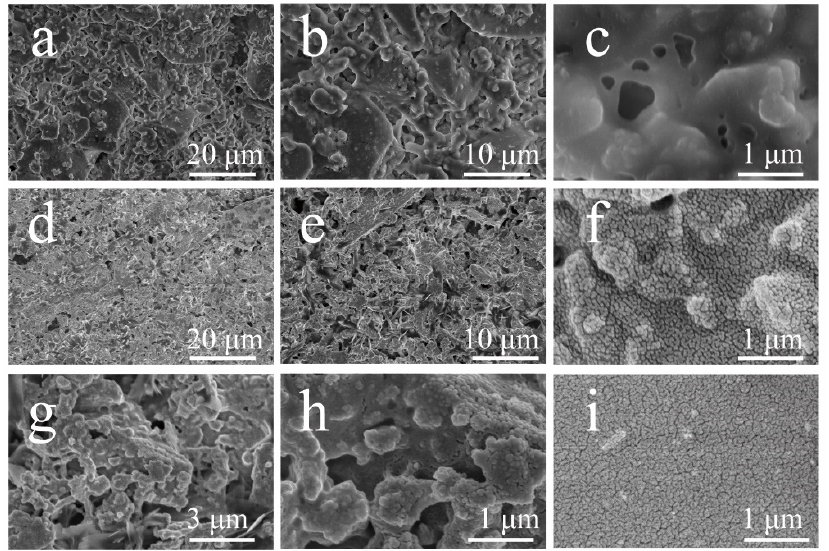
Figure 3. FE-SEM microstructure of the coating about different part: ( a – c ) surface morphology of GPs; ( d – f ) surface morphology of GP-SHCs; ( g , h ) cross-sectional morphology of GP-SHCs, ( i ) bottom morphology of GP-SHCs.